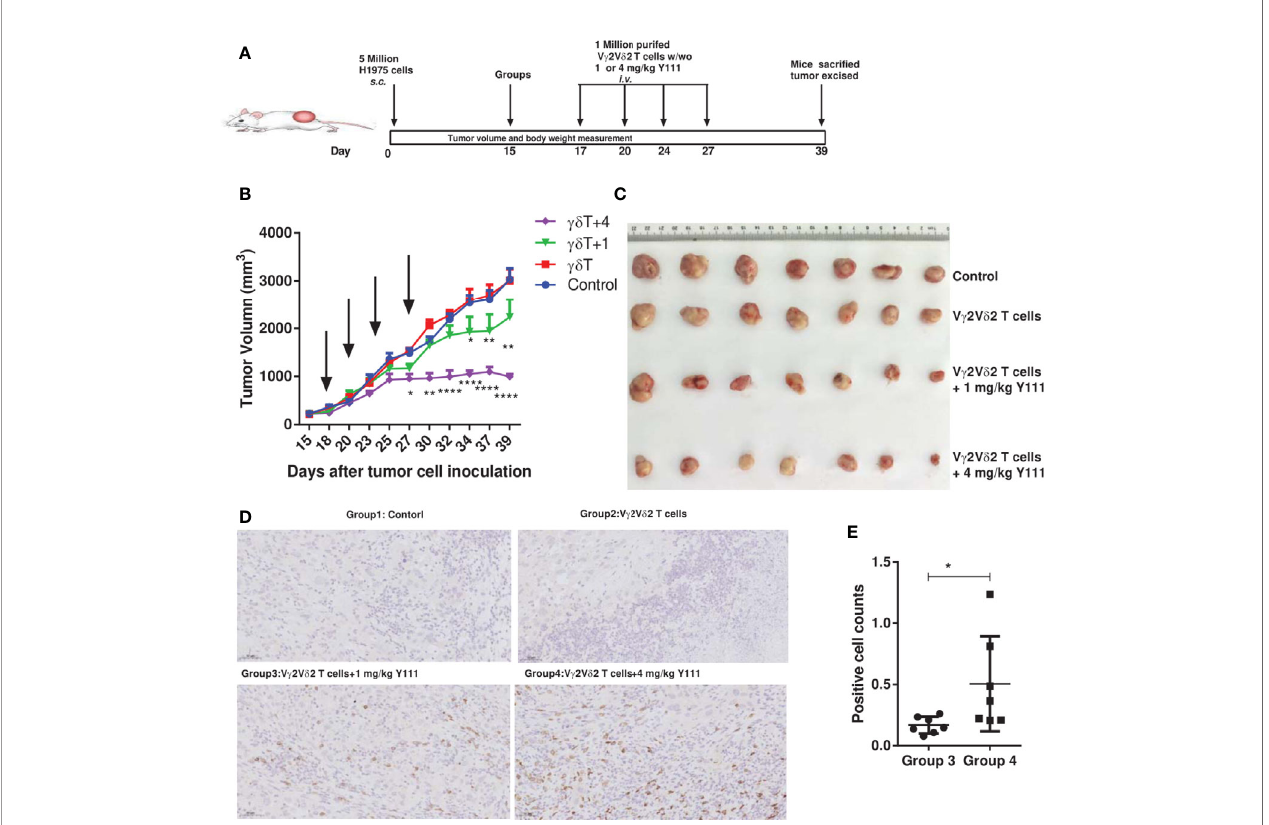
FIGURE 7 | The combined usage of transfused V g 2V d 2 T cells with Y111 signi fi cantly inhibited tumor growth in vivo . (A) Experimental schema of protocols for establishing xenograft in NPG mice and evaluating the anti-tumor therapeutic ef fi cacy of different treatments. Immunode fi cient NPG mice were s.c. inoculated with H1975 NSCLC cells on Day 0. After seventeen days, mice were treated with i.v. transfused V g 2V d 2 T cells w/wo 1 or 4 mg/kg Y111. These treatments were repeated twice per week for 2 weeks. Mice treated PBS were used as control. (B) The pooled tumor growth curves for NPG mice in four groups. The black arrows indicated the treatment time point. Data are mean ± SEM with 7 mice per group, **** p < 0.0001, ** p < 0.01, * p < 0.05 versus control group, two-way ANOVA followed by Dunnett test. (C) Inspection of tumor tissues excised from each group at the end of the study. (D) Representative IHC photomicrographs of tumors excited from mice stained with the anti-human CD3 antibody. Magni fi cation, 20X. (E) In fi ltrated and accumulated T-cell counts at the tumor sites for mice received puri fi ed V g 2V d 2 T cells with 1 or 4 mg/kg Y111. Quantitative analysis of V g 2V d 2 T cells was done by counting positive dots in a total of 70 fi elds from 14 mice. We did not fi nd the accumulation of V g 2V d 2 T cells in the other two groups. Each dot represented one mouse. Data were presented as mean ± SEM, * p < 0.05, Mann Whitney U